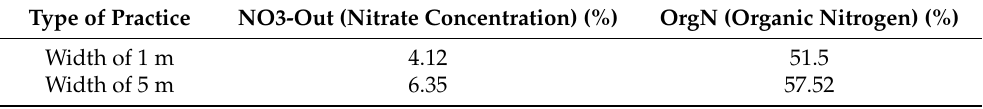
Table 6. Percentage reduction in the concentration of organic nitrogen and nitrate in different widths.